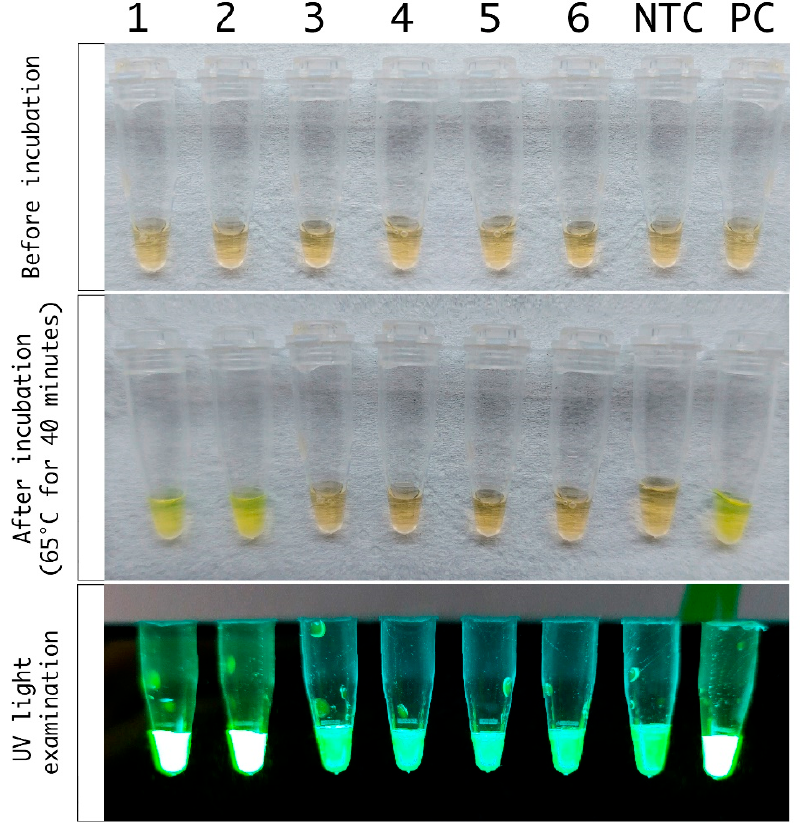
Figure 2. Tc-LAMP PrintrLab DNA extraction of samples from case Tx-RCD 5. Panel A: Strip of Tc-LAMP microtubes before amplification. Panel B: Naked-eye visualization of Tc-LAMP microtubes after amplification. Panel C: Visualization using the P51 TM molecular fluorescence viewer with yel-